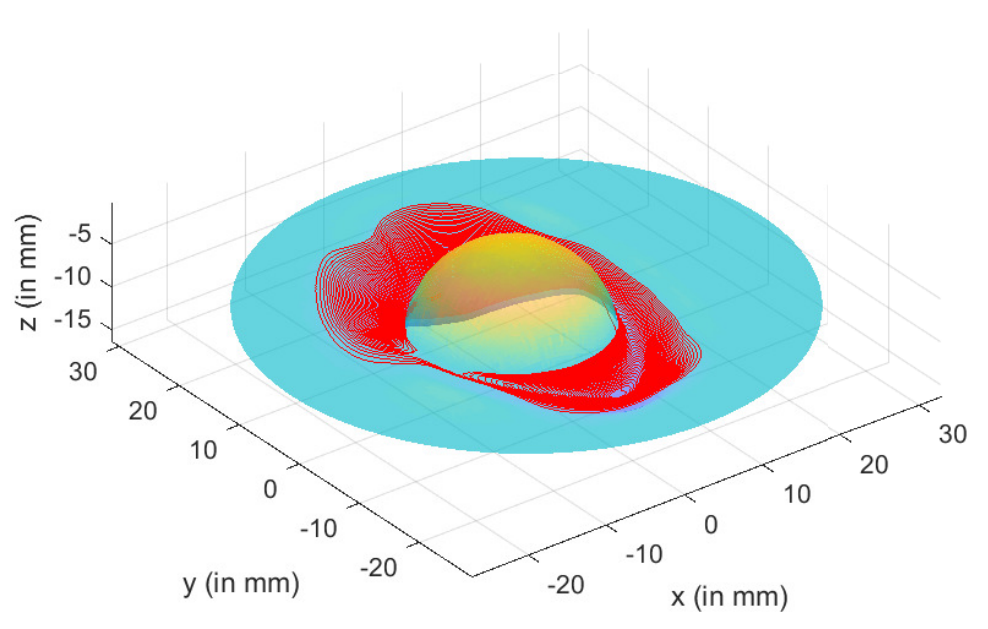
Figure 7. Tool trajectory—one